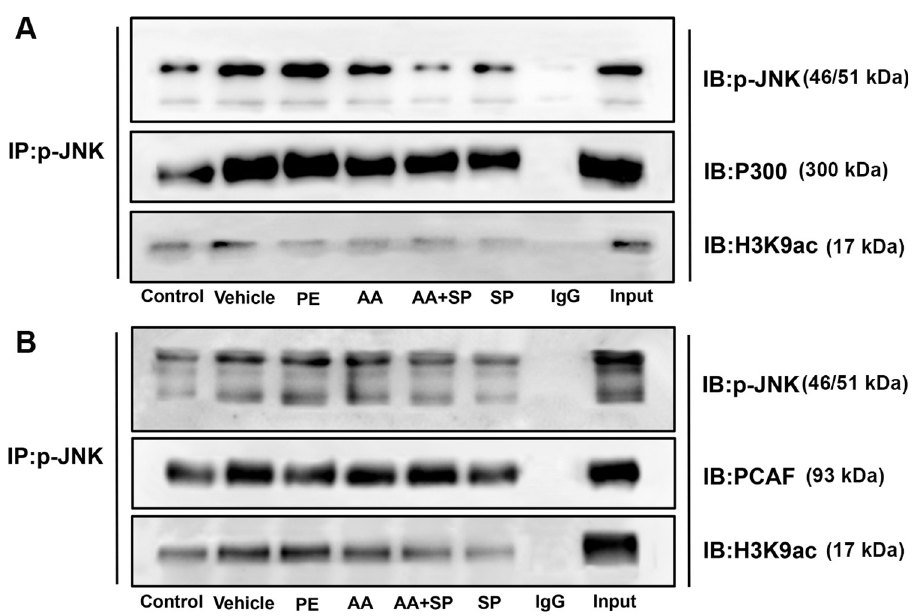
Fig 3. p-JNK directly interacted with HATs and altered H3K9ac acetylation in primary mouse cardiomyocytes. (A and B) Co-immunoprecipitation (CoIP) of cell lysates from mouse myocardial cells exposed to six different experimental conditions with anti-p-JNK-protein G magnetic beads and immunoblot (IB) with an anti-P300-HAT, anti-PCAF-HAT, anti-H3K9ac, or anti-p-JNK antibody for the evaluation of protein expression. PE: phenylephrine; DMSO: dimethylsulfoxide; AA: anacardic acid; SP: SP600125 (JNK inhibitor); IP: immunoprecipitation; IB: immunoblotting; Input: positive control; IgG: negative control. Images are representative of three qualitatively similar independent